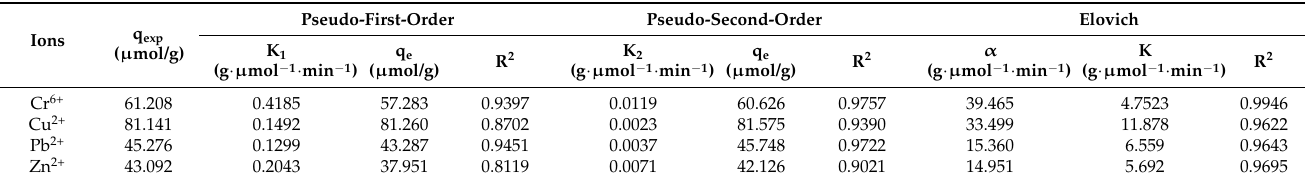
Table 1. Fitted parameter values of pseudo-first-order, pseudo-second-order, and Elovich kinetic models.